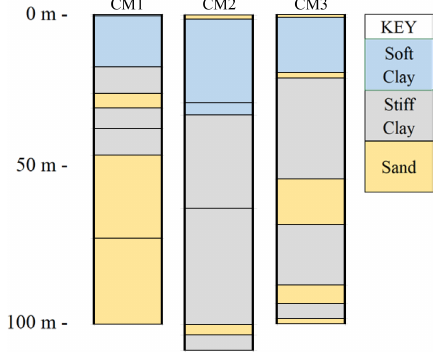
Figure 3. Soil stratification at benchmark locations.